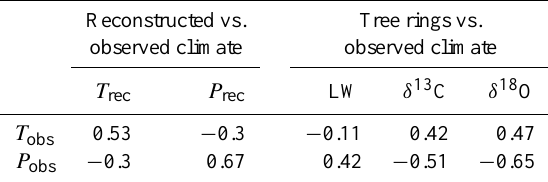
Table 1. Correlation between (left column) observed and recon- structed summer climatic conditions at the Fontainebleau Forest for the 1960–2000 period and (right column) correlation between tree rings and observed climatic conditions. Reconstructed vs. Tree rings